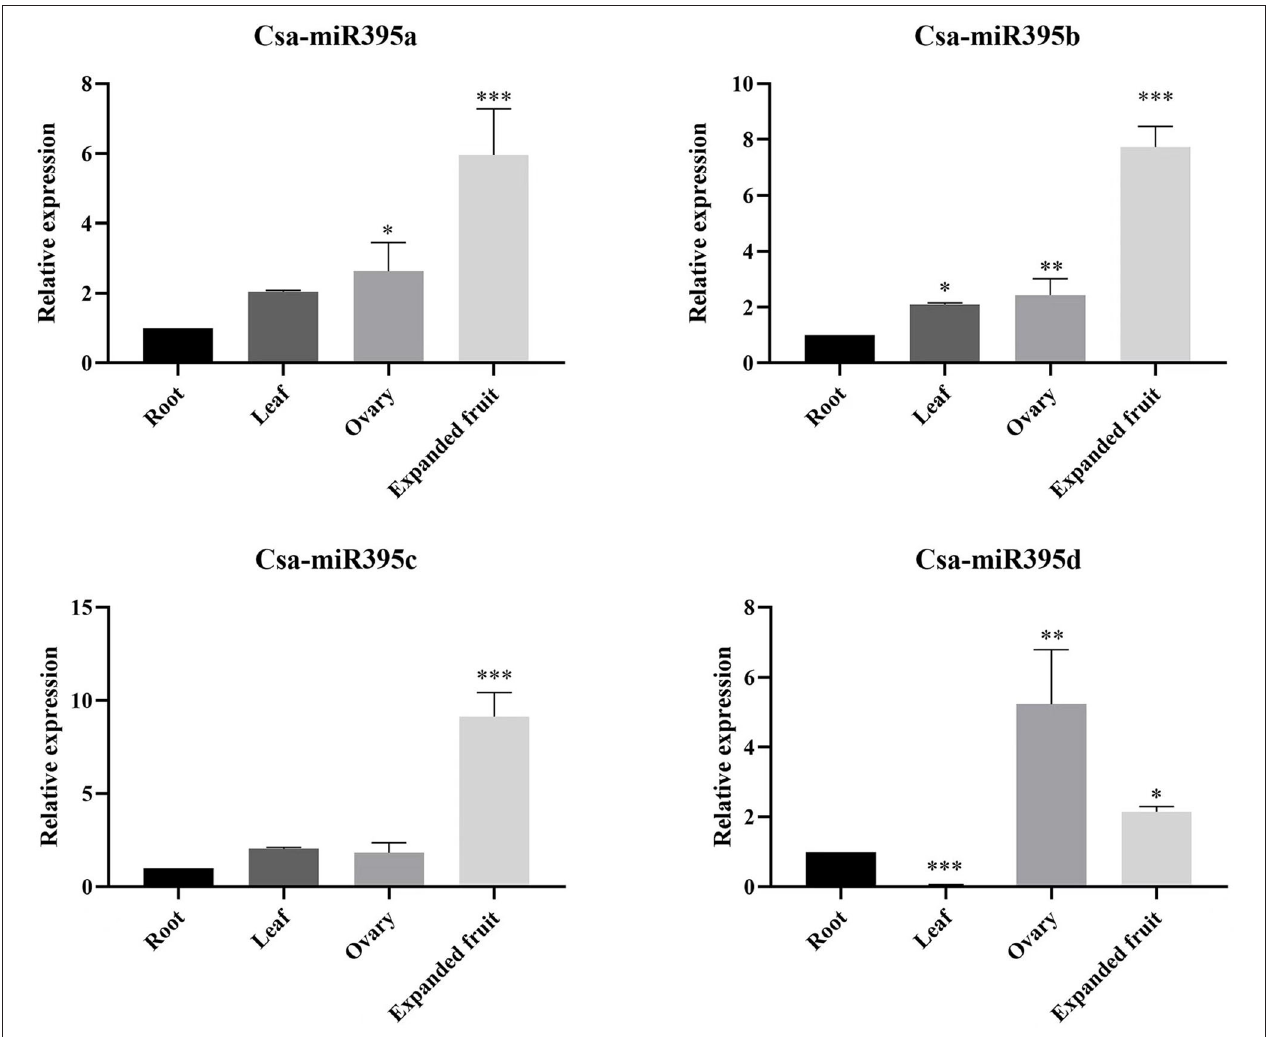
FIGURE 4 | Expression patterns of Csa-miR395s in the different tissues (root, leaf, ovary, and expanded fruit). The X-axis represents the tested tissue samples. The Y-axis represents the relative expression level of a transcription factor. The values represent the means ± SDs. Asterisks represent significant difference at p ≤ 0.05 (*), p ≤ 0.01 (**), and p ≤ 0.001